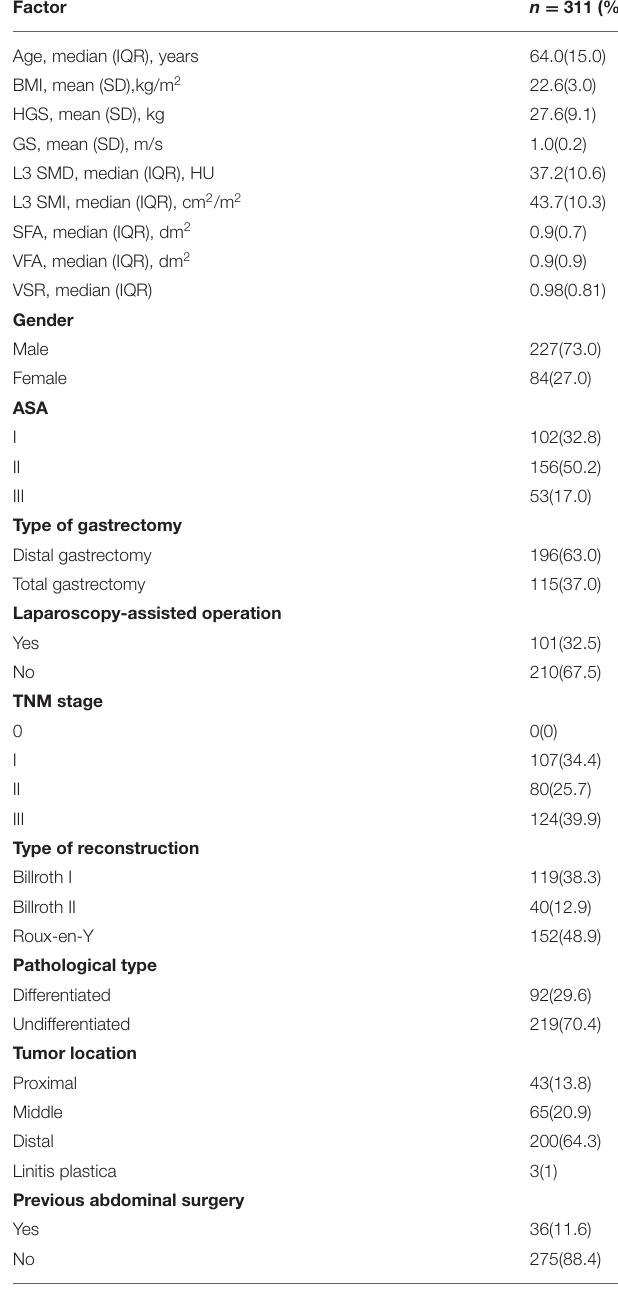
TABLE 1 | Baseline characteristics of the